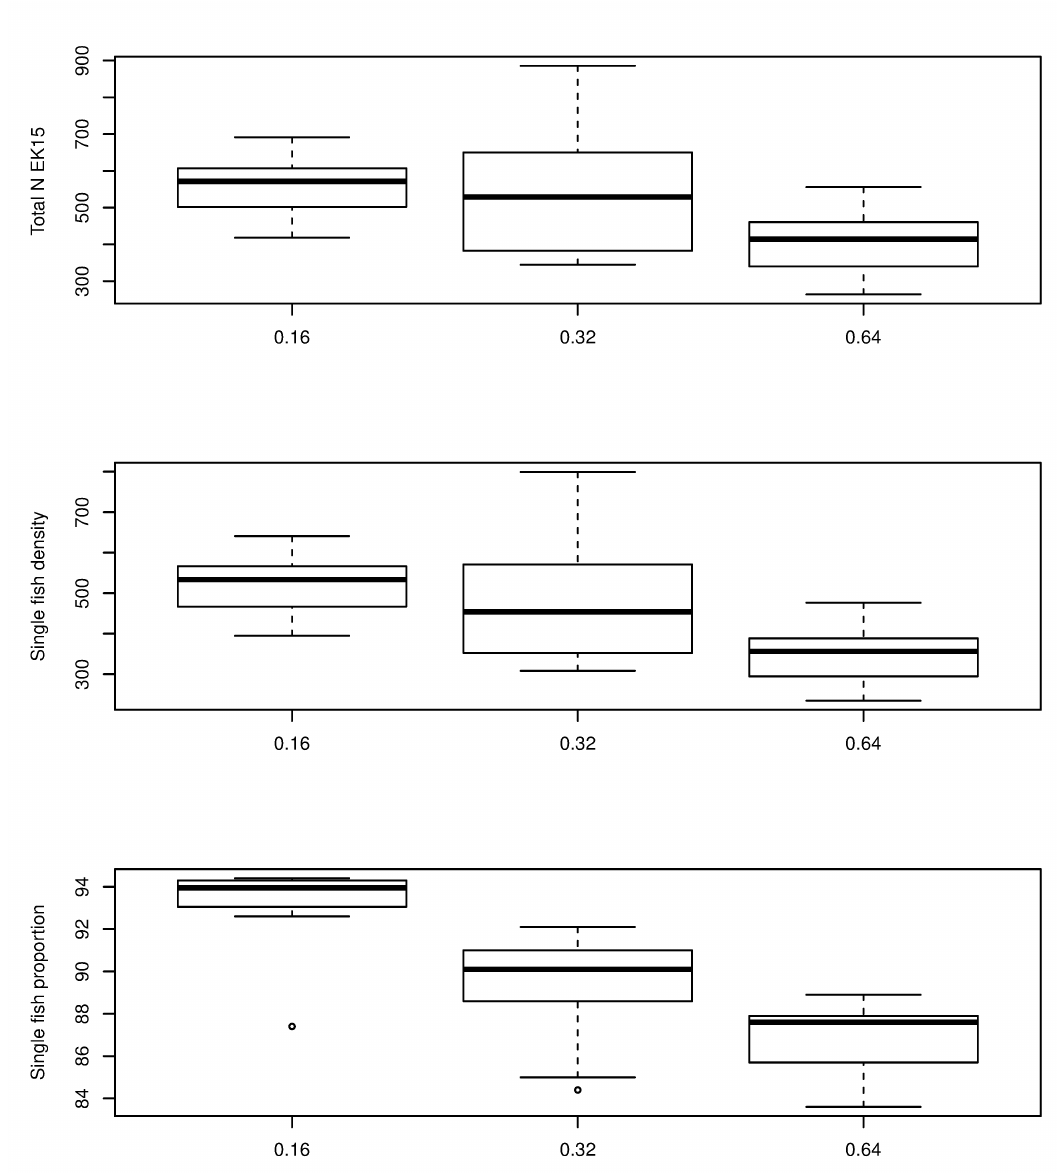
Figure 5. Bloxplots (bold horizontal line = median, box showing 25 and 75 percentiles, whiskers show min - max) showing EK15-based estimates of the total density ( above ), single fish density ( middle ) and proportion of single fish plotted against tree different pulse durations ( below ).